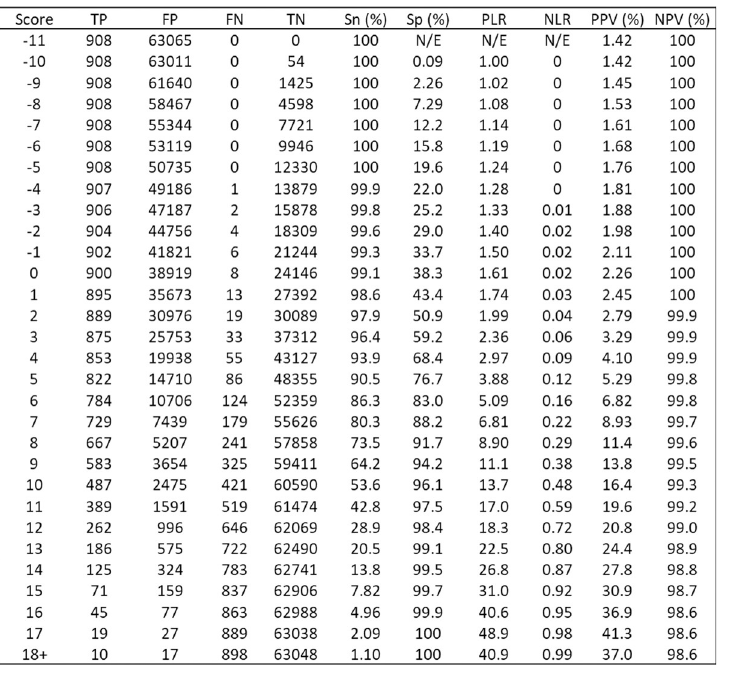
Fig 3. Full breakdown of STm model performance. FN, false negative; FP, false negative; N/E, not estimable; NLR, negative likelihood ratio; NPV, negative predictive value; PLR, positive likelihood ratio; PPV, positive predictive value; Sn, sensitivity; Sp, specificity; STm, symptoms and tests model; TN, true negative; TP, true positive.